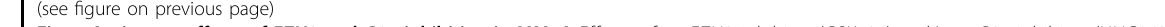
Fig. 1 Antitumor effects of EZH2 and G9a inhibition in MM. A Effects of an EZH2 inhibitor (GSK126) and/or a G9a inhibitor (UNC0638) on MM cell viability. Shown are summarized cell viability assays in MM cell lines treated with the indicated drugs (1 μ M each) for 3 or 6 days. Results are normalized to cells treated with DMSO. The data are presented as means of three biological replications; error bars represent standard errors of the mean (SEMs). B Western blot analysis of H3K9 and H3K27 methylation in RPMI-8226 cells treated with the indicated inhibitors (1 μ M each, 6 days). C Tumor growth in mice injected with RPMI-8226 cells pretreated with DMSO or GSK126 + UNC0638 (1 μ M each). Growth curves are presented as means of fi ve biological replications. Resected tumors are shown below. D Results of cell viability assays using indicated MM cell lines treated with an EZH2 inhibitor (EPZ-6438, 1 μ M) and/or a G9a inhibitor (UNC0642, 1 μ M). Shown are means of three biological replications; error bars represent SEMs. E qRT-PCR analysis of EZH2 and EHMT2 in the indicated MM cell lines. Results are normalized to ACTB expression. Shown are means of three technical replications; error bars represent SEMs. F Results of cell viability assays of MM cell lines treated for 14 days with the indicated drugs (1 μ M each). Shown are means of fi ve biological replications; error bars represent SEMs. G Comparison of EZH2 mRNA expression among normal plasma cells (NPC, n = 15), newly diagnosed MM (NMM, n = 69) and relapsed MM (RMM, n = 28) (left), and EHMT2 mRNA expression among normal plasma cells (NPC, n = 22), monoclonal gammopathy of undetermined signi fi cance (MGUS, n = 44) and smoldering multiple myeloma (SmMM, n = 12) (right) using the indicated datasets. H Kaplan – Meier curves showing the effect of EZH2 or EHMT2 expression on overall survival of newly diagnosed MM patients from the indicated datasets. MST mean survival time, NR not reached. * P < 0.05, ** P <